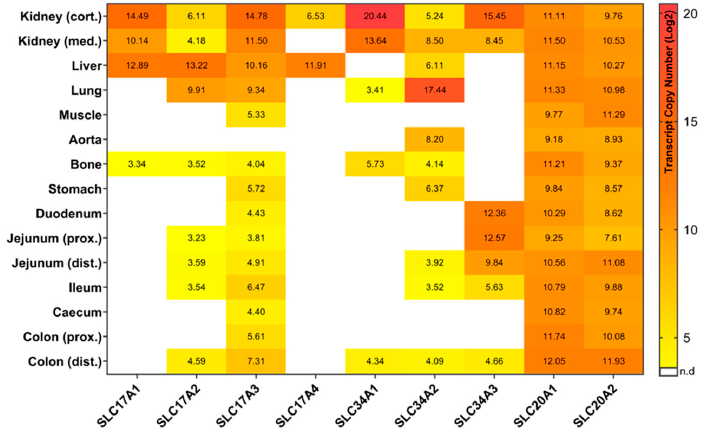
Figure 1. Heatmap of the gene expression of nine sodium / phosphate co-transporters in pigs on a standard commercial diet (Trial 1). In total five German Landrace pigs were fed a standard P diet for six months. Transcript copy numbers of all nine sodium / phosphate co-transporter were measured in 15 tissues by qRT-PCR. Copy numbers were displayed as log2 values.